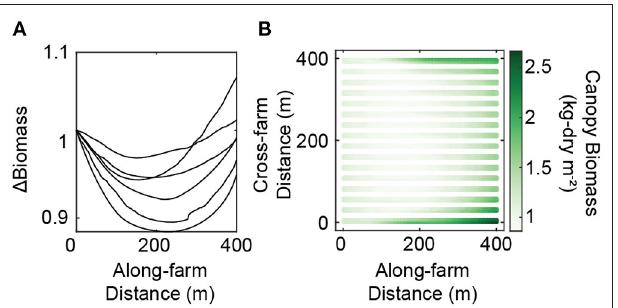
FIGURE 8 | (A) Along-farm difference in biomass (averaged in the cross-farm, y-direction) relative to the start of the farm ( x = 0) on the day of maximum biomass per year ( n = 6) for full-farm Simulation C. Simulation C includes all within-farm physics, transport, and uptake. (B) Planar view of canopy biomass (kg-dry m -2 ) in the year 2003 on the day of maximum canopy (day of year, 149) for full-farm Simulation C.